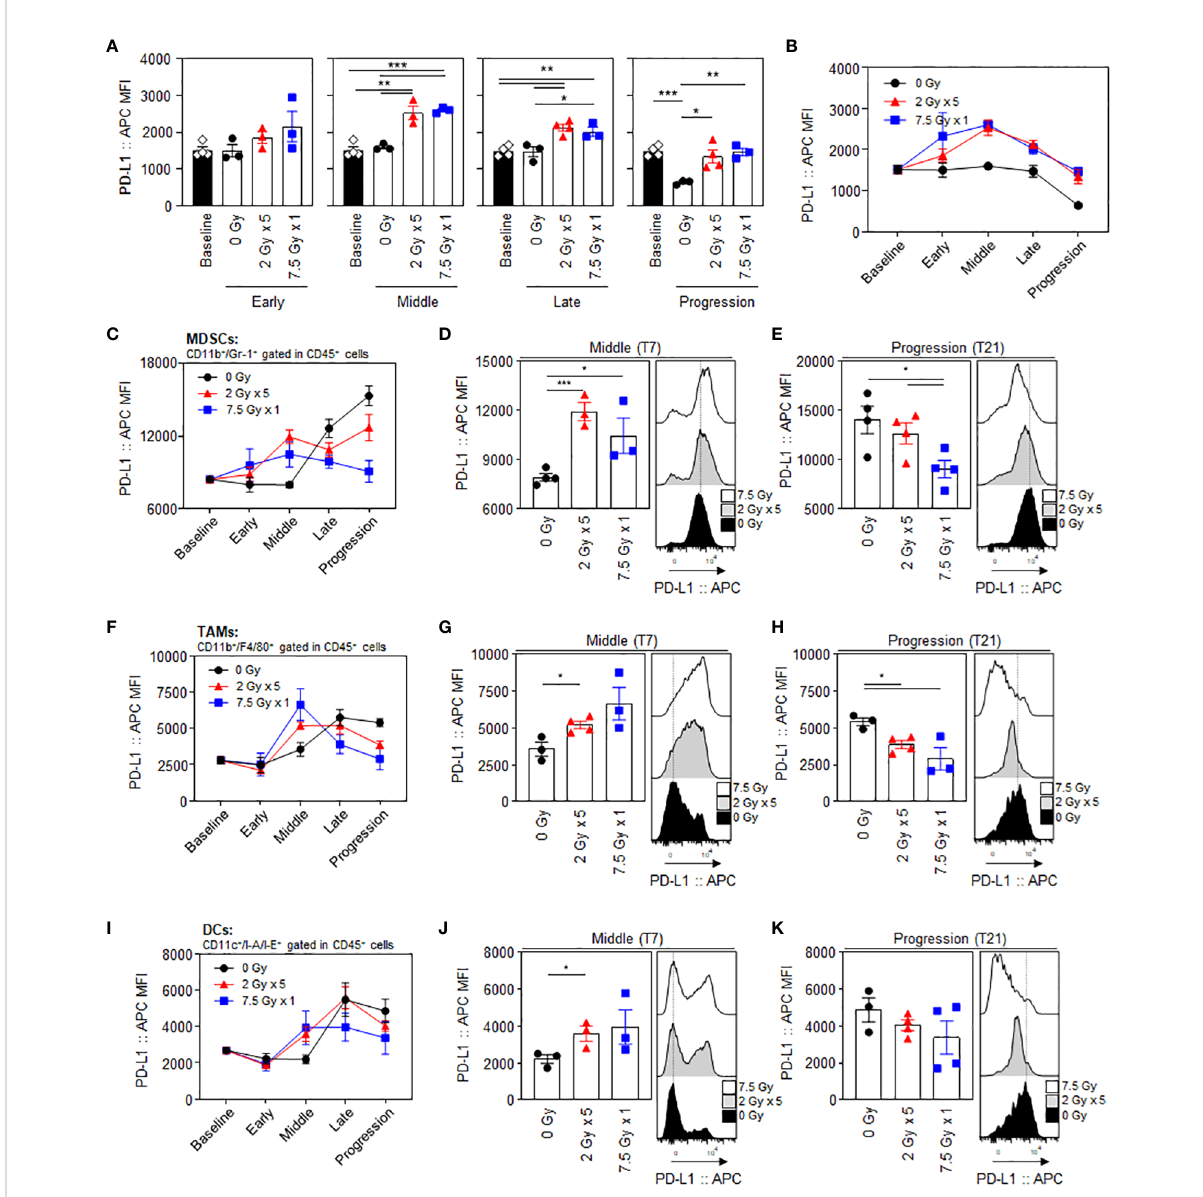
FIGURE 2 Radiation-induced increase and dynamic alterations in PD-L1 expression levels in tumor cells and intratumoral MDSCs, TAMs, and DCs. Sequential alterations in the PD-L1 MFI values of tumor cells depicted using (A) individual bar and (B) line graphs. PD-L1 MFI values in MDSCs depicted using (C) line graphs, and a comparison of the experimental groups at the (D) middle (T7) and (E) progression (T21) phases: black dashed lines indicate the geometric mean values of 0 Gy at each time point. PD-L1 MFI values of (F – H) TAMs and (I – K) DCs: (F, I) line graphs and comparisons of the experimental groups at the (G, J) middle (T7) and (H, K) progression (T21) phases. All data are presented as mean ± SEM. * P < 0.05, ** P < 0.01, and *** P < 0.001 based on unpaired two-tailed t -test. Results of one-way ANOVA analyses for each time phase are listed in Table S4. These fi gures are based on the representative data obtained from at least two independent experiments. The histograms of (D, E) , (G, H) , and (J, K) are from representative individual samples. Abbreviations: PD-L1, programmed death ligand-1; MDSCs, myeloid-derived suppressor cells; TAMs, tumor-associated macrophages; DCs, dendritic cells; MFI, mean fl uorescence intensity; SEM, standard error of the mean; ANOVA, analysis of